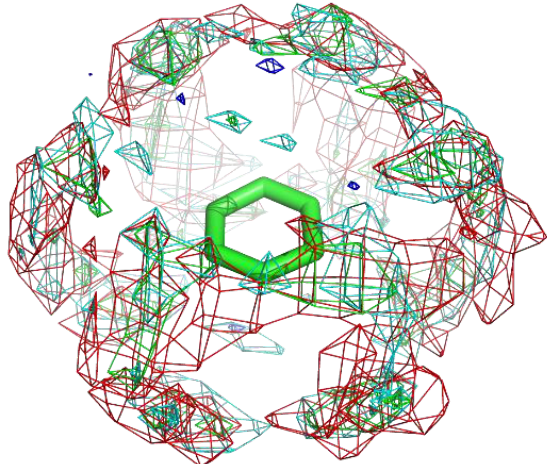
Figure 7. The residue interaction profile of catechol. Green, cyan, gray, blue, and red meshes indicate profiles of hydrophobic, hydrophilic, aromatic, basic, and acidic residues, respectively. The molecule structure is that of catechol.